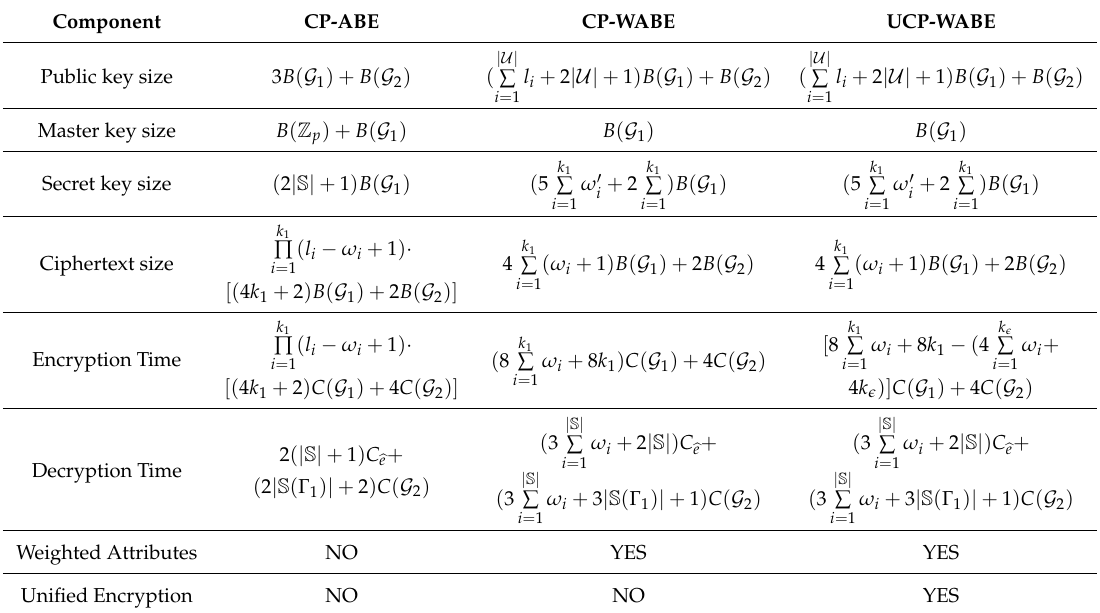
Table 2. Comprehensive